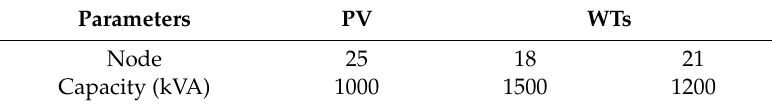
Figure 3. Diagram of the modified IEEE 33-node system. Table 1. Detailed installation parameters of DGs.